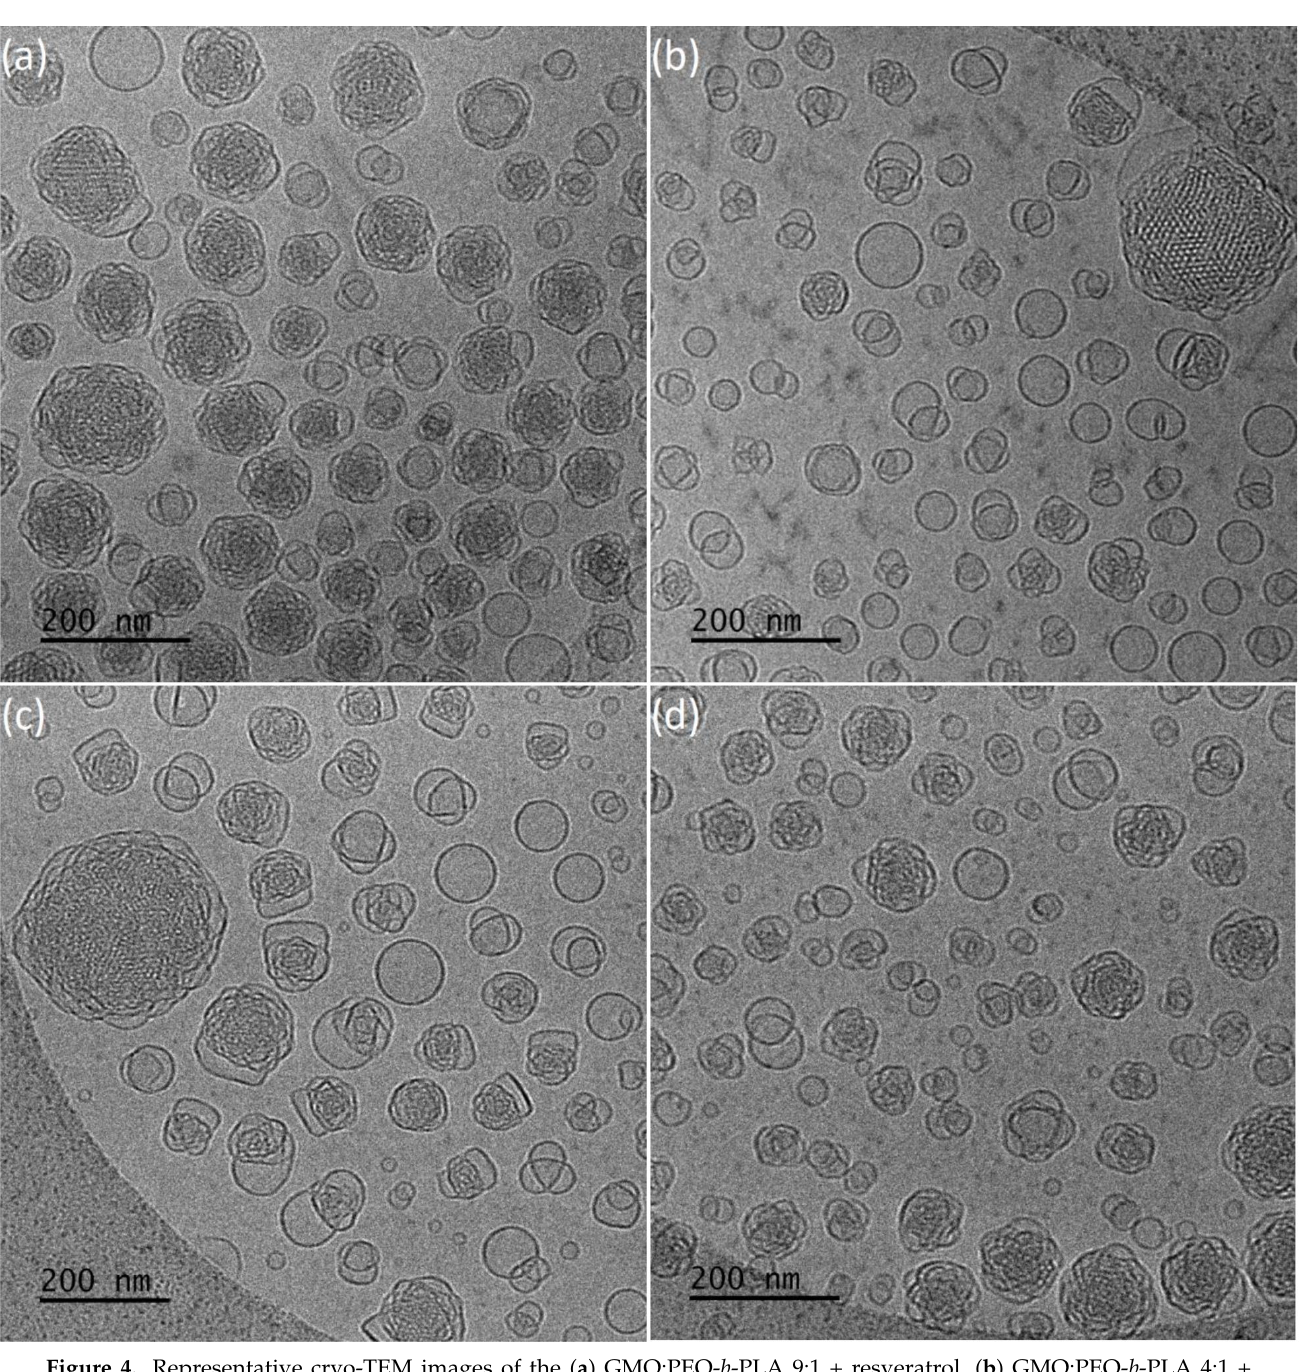
Figure 4. Representative cryo-TEM images of the ( a ) GMO:PEO- b -PLA 9:1 + resveratrol, ( b ) GMO:PEO- b -PLA 4:1 + resveratrol, ( c ) GMO:PEO- b -PMEC 9:1 + resveratrol, ( d ) GMO:PEO- b -PMEC 4:1 +